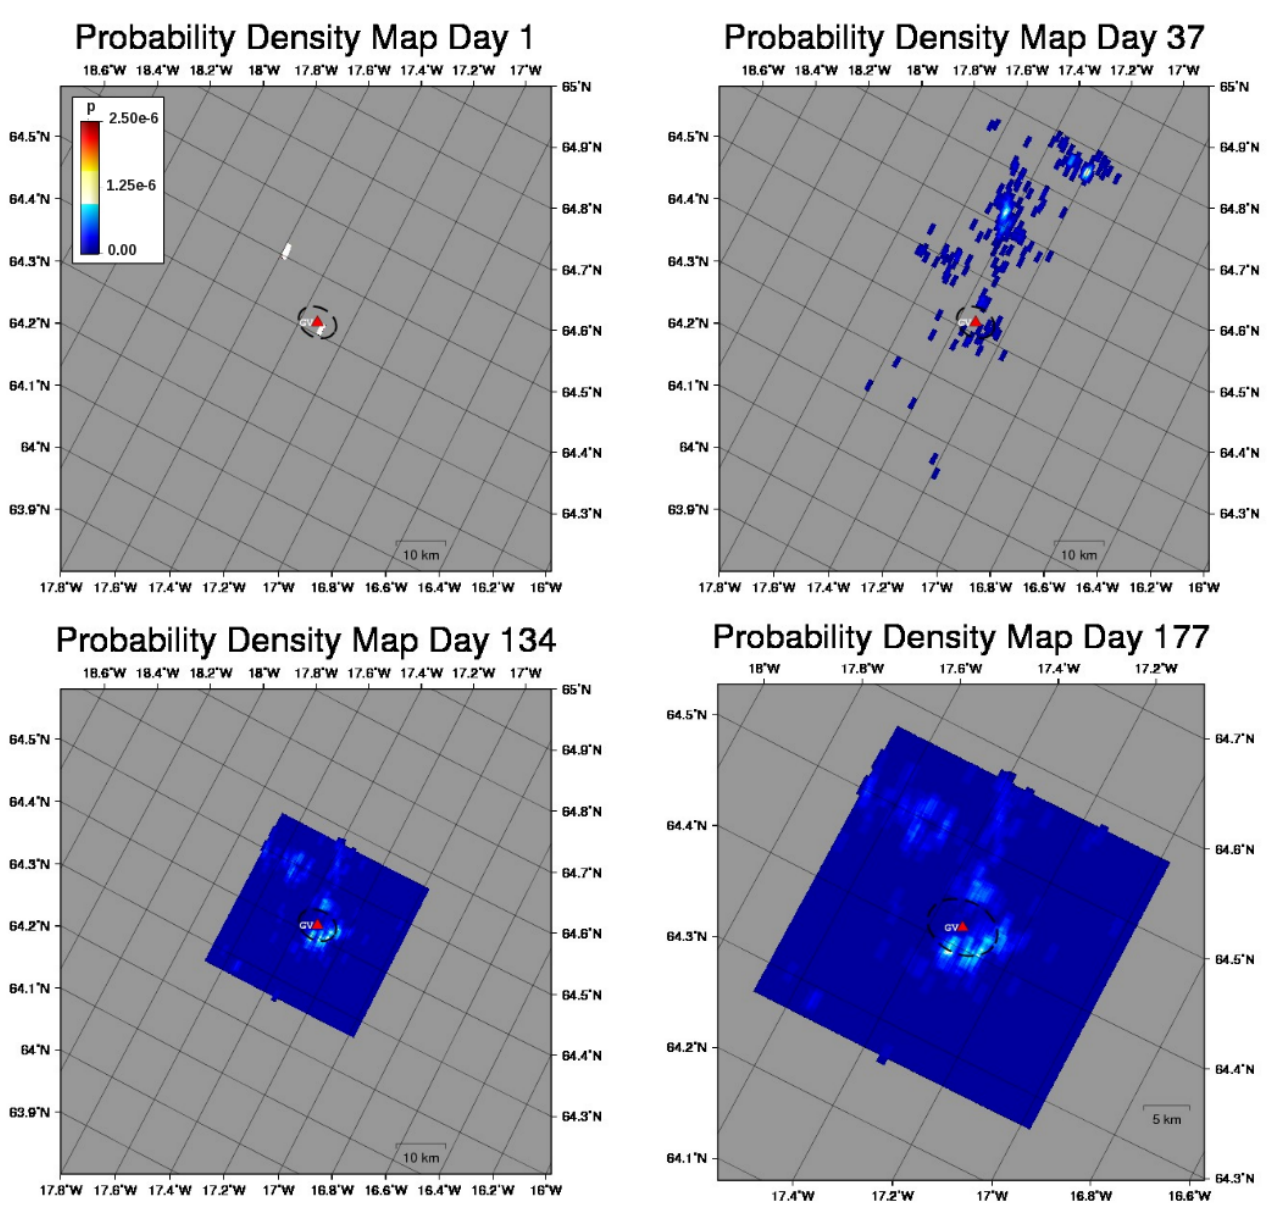
Figure 16. Spatial Probability Density Maps for volcanic activity preceding Grimsv¨otn’s 2011 eruption, where the black ellipse outlines the approximate perimeter of the caldera. The plot for day 177 has been enlarged to emphasize regions with a higher probability of vent formation within the quantitatively constrained